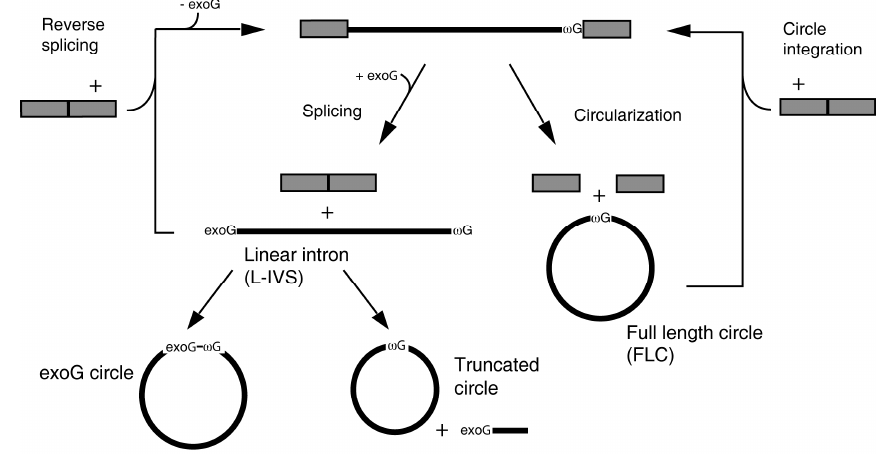
Figure 1. Processing of group I introns. The splicing pathway (left part) is initiated by attack at the 5 ′ splice site by an exogenous guanosine cofactor (exoG). By two consecutive transesterification reactions the intron splices out of the precursor RNA resulting in ligated exons (grey boxes) and a free linear intron (L-IVS) with the exogenous guanosine (exoG) coupled to the 5 ′ end. In some introns, attack of the 3 ′ terminal guanosine ( ω G) at an internal site in the L-IVS results in formation of a truncated circular intron RNA and release of a small 5 ′ end fragment. Alternatively, the attack takes place at the three phosphates of the exoG leading to formation of a circular RNA that incorporates the guanosine cofactor and release of pyrophosphate. The L-IVS can reverse splice into a cognate site as shown, or alternatively, into a new sequence context (intron transposition). The circularization pathway (right part) is initiated by hydrolysis at the 3 ′ splice site followed by an attack of the ω G at the 5 ′ splice site. This produces a full-length intron circle (FLC) and un-ligated exons. The FLC can integrate into a target RNA.